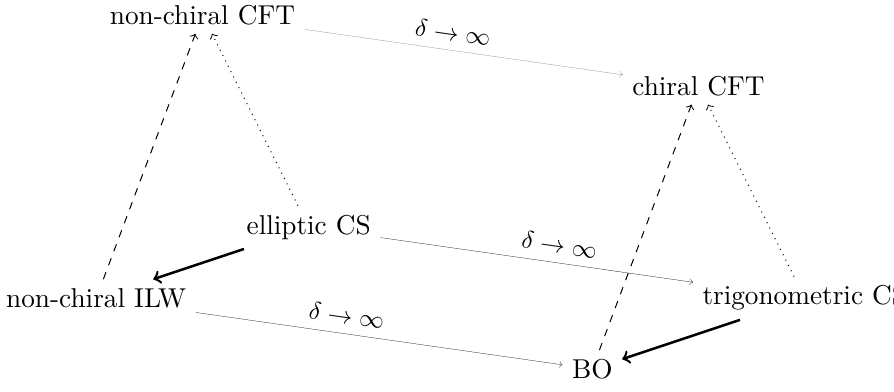
Figure 1 . A diagram indicating the various relationships between the models discussed here: the thick lines indicate particular continuum limits, the dashed lines first quantizations and the dotted lines second quantizations; the lines marked by δ indicate trigonometric → ∞